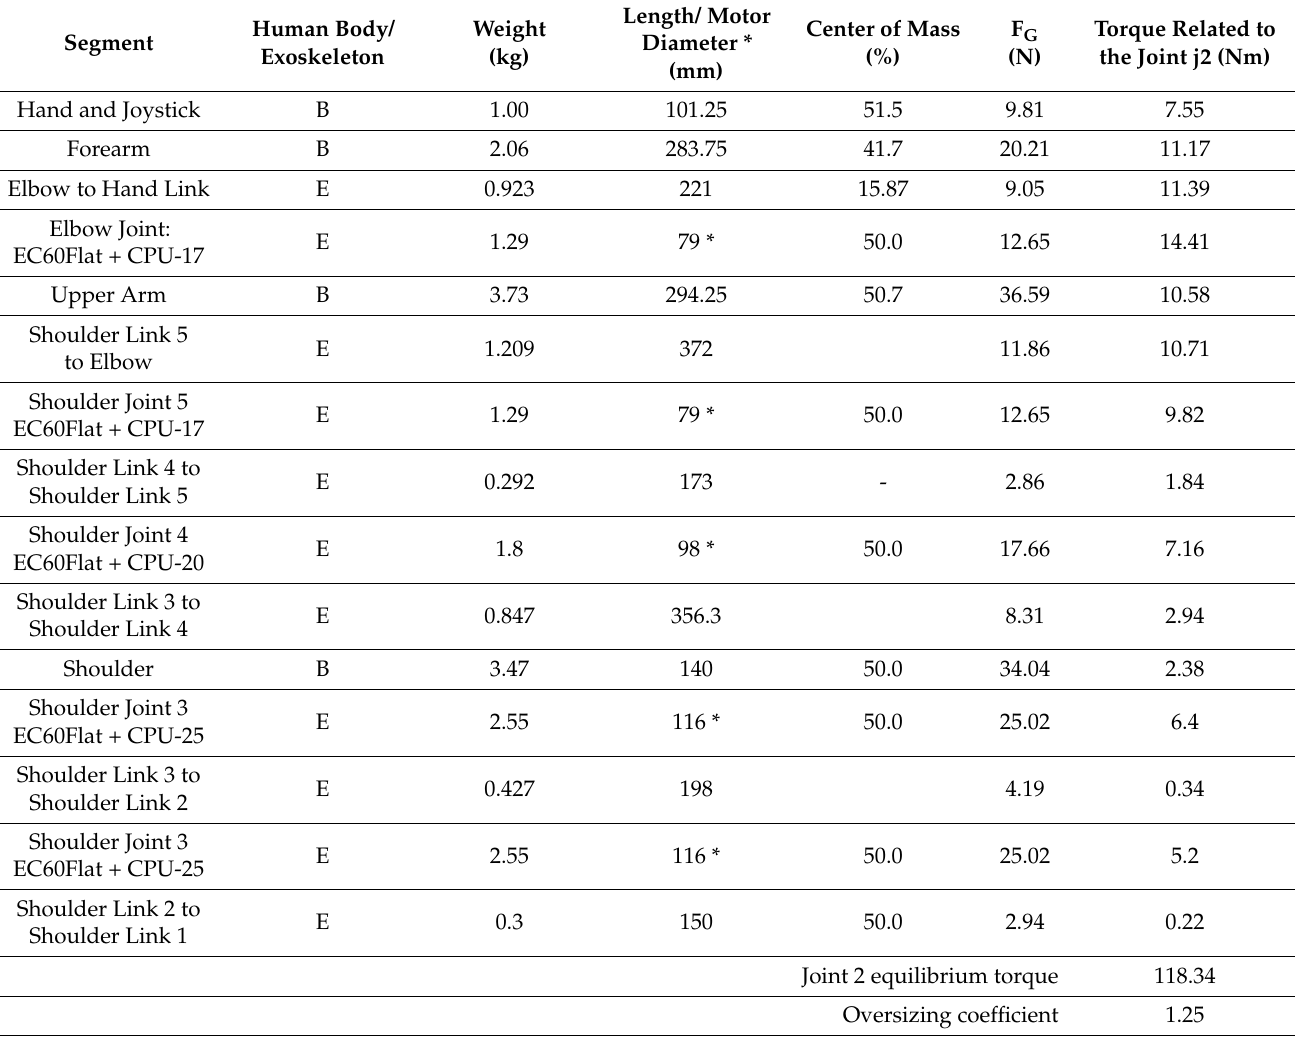
Table 4. Exoskeleton joint 2 necessary torque.